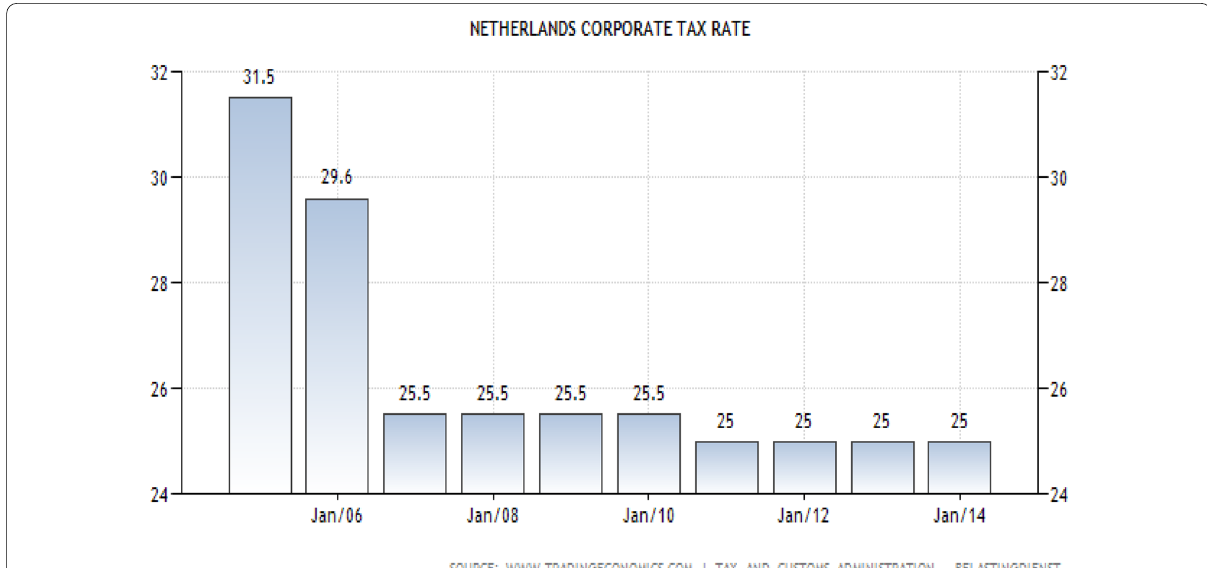
Fig. 2 German corporate tax rate